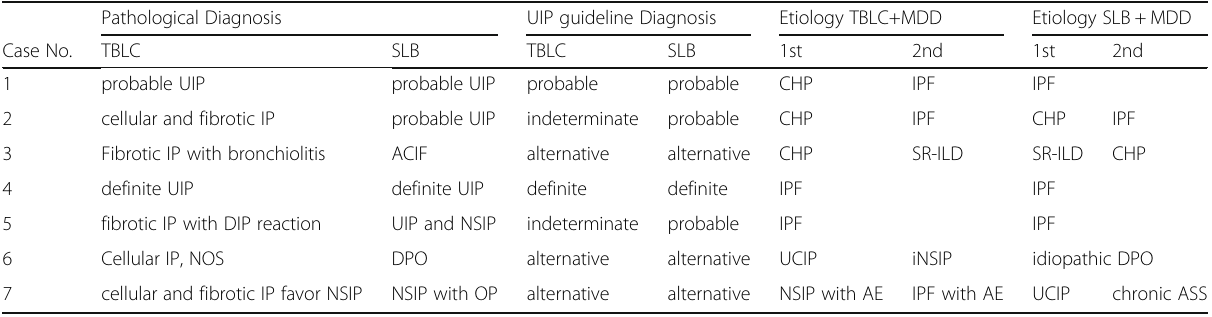
Table 2 Pathological diagnosis in all 7 cases Pathological Diagnosis UIP guideline